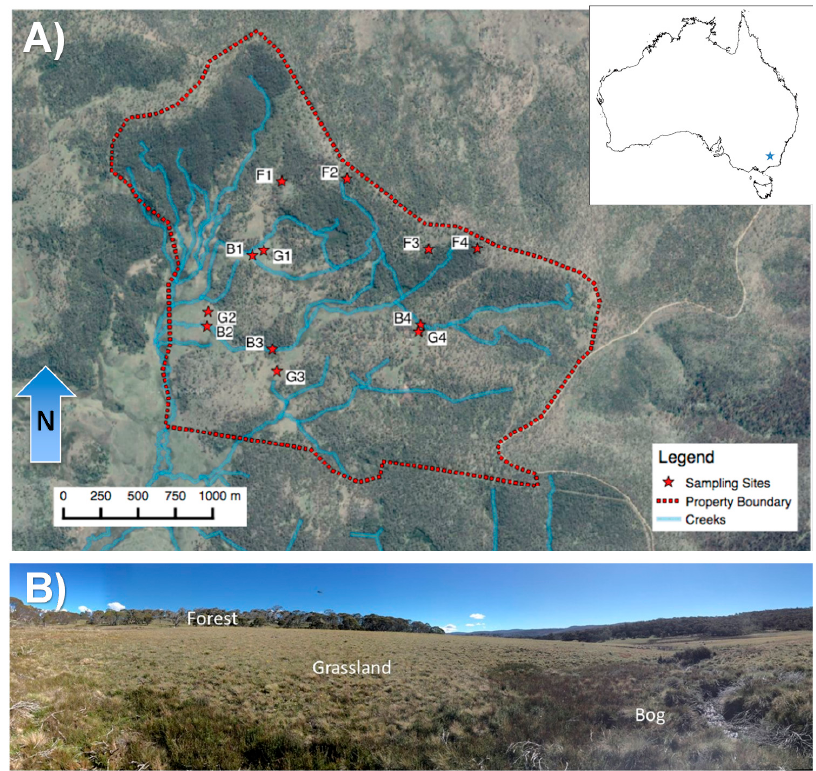
Figure 1. ( A ) Location of 548 ha experiment area (inset of Australia), and map of sampling sites within watershed and nearby streams. ( B ) Landscape-level photograph of the vegetation gradient from Sphagnum -dominated bog in foreground to eucalyptus-dominated forest in background. Abbreviations are F = forest, G = grassland, and B = bog. The numbers after the letter represent which transect the sampling location belongs to. Map and Image sources: L. Ingram andEsri, Maxar, GeoEye, Earthstar Geographics, CNES/Airbus DS, USDA, USGS, AeroGRID, IGN, and the GIS User Community. Photograph source: M.D.